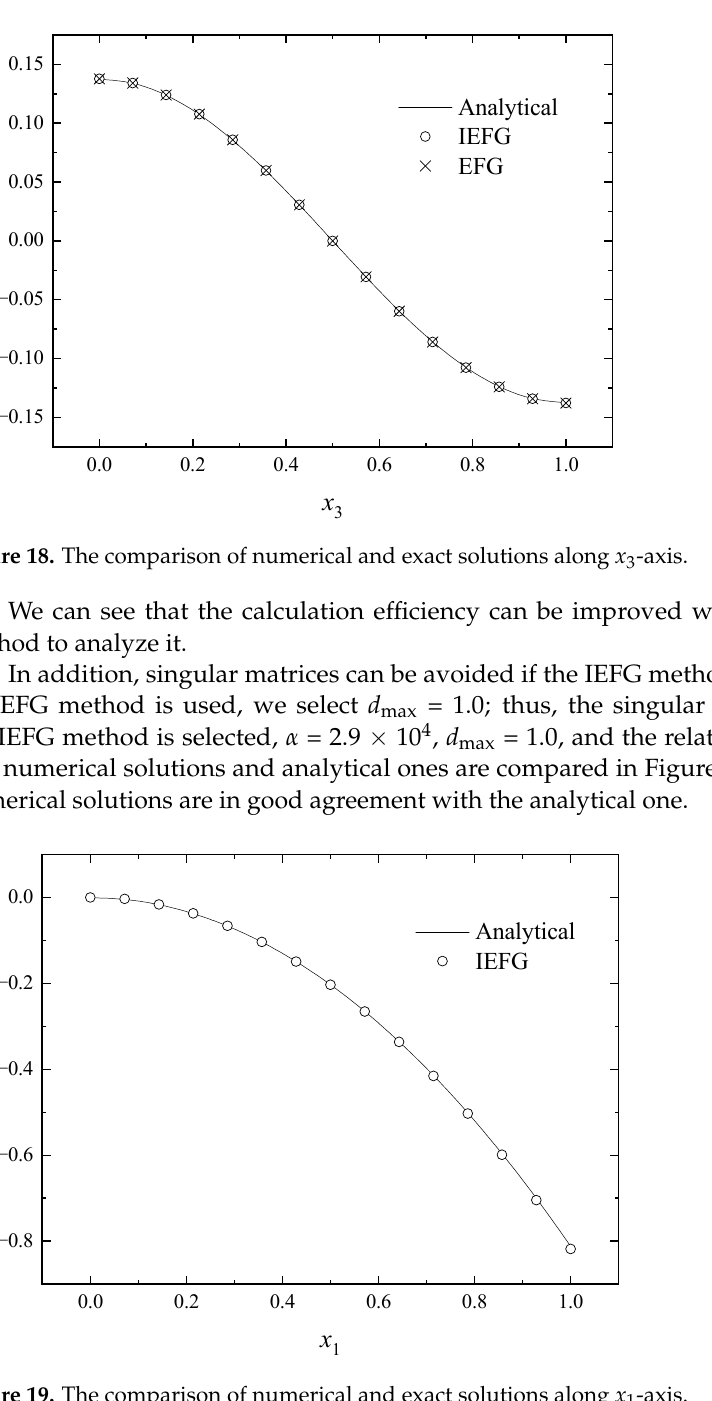
Figure 17. The comparison of numerical and exact solutions along x 2 -axis.